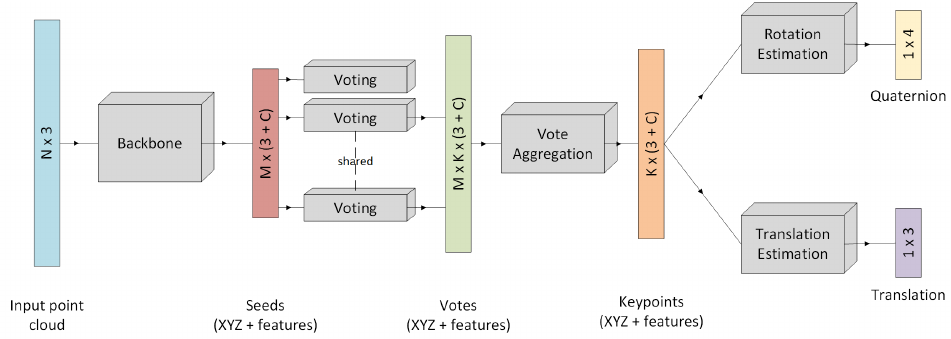
Figure 8. Overview of P2P-Net architecture. N is the number of points, M refers to the number of seeds found by the backbone and K is the number of predefined